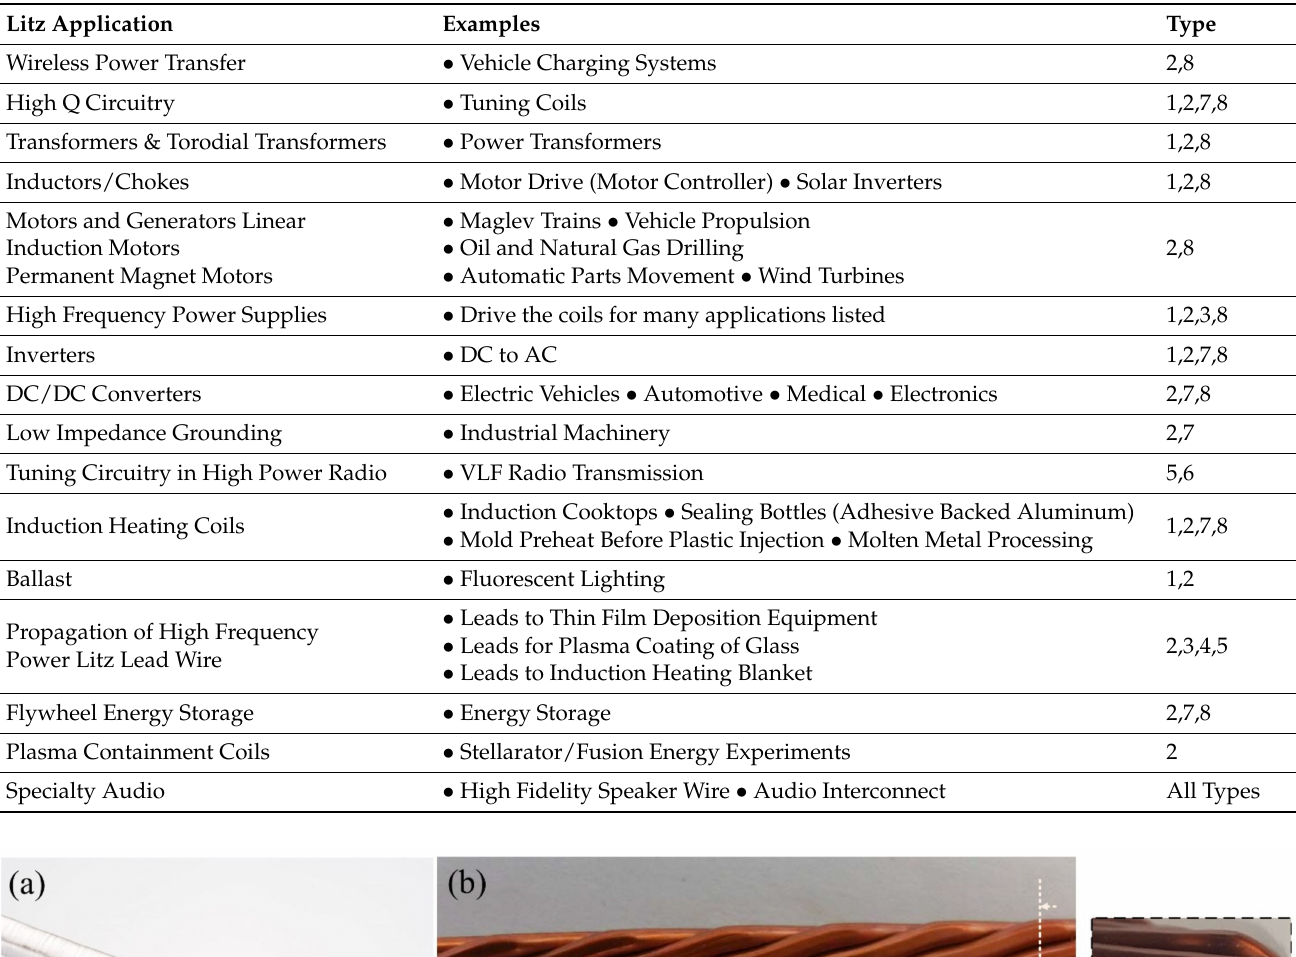
Table 2. Applications of different types of Litz wire [44].